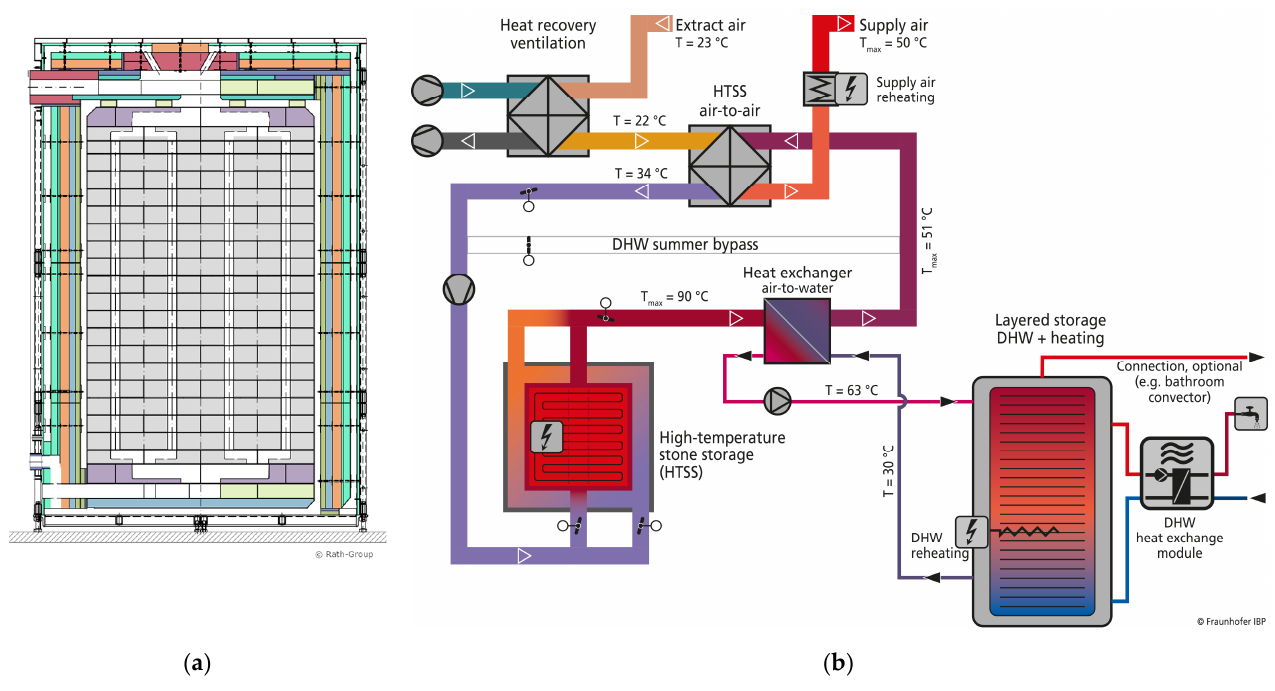
Figure 3. ( a ) Technical drawing of the HTSS including the stone core made of bricks, the different insulation layers, and air channels. ( b ) Sketch of the integration of an HTSS into the technical building equipment for supplying a building with space heating and domestic hot water. It shows the operating state with simultaneous hot water preparation and supply air heating (space heating).